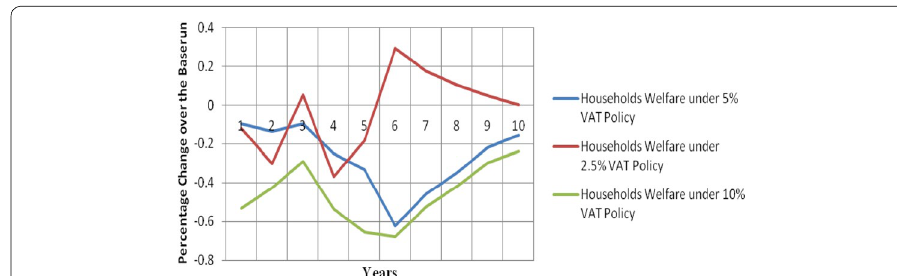
Fig. 14 Percentage change in households’